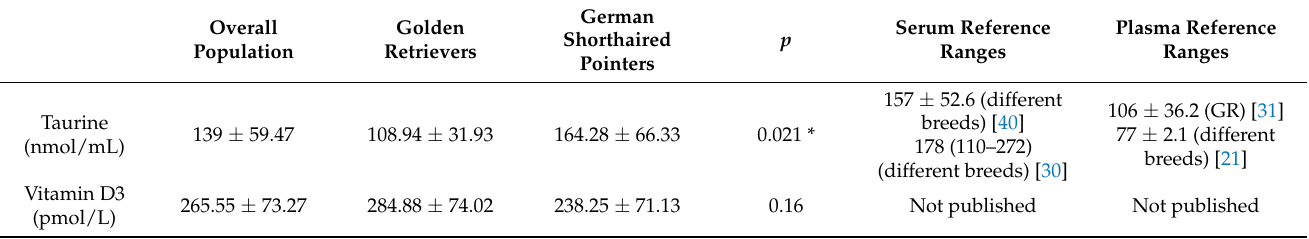
Table 2. Taurine and vitamin D3 serum concentrations in the Golden Retrievers and German Shorthaired Pointers, their comparisons, and the reference ranges proposed in the literature. Golden Retrievers